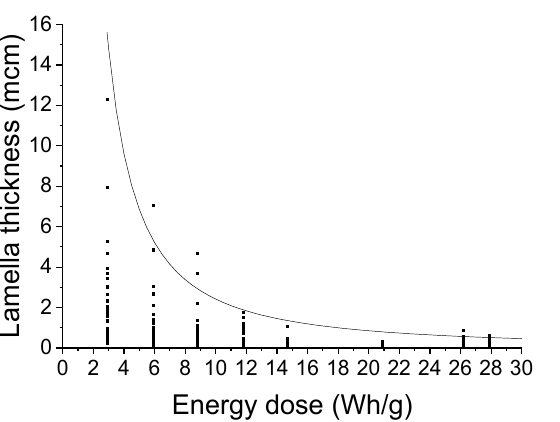
Figure 9. Dependence of lamella thickness in Ni 36 Al 27 Co 37 powder on MA energy dose.